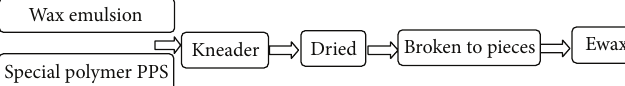
Figure 1: The preparing process for solid lubricant Ewax.